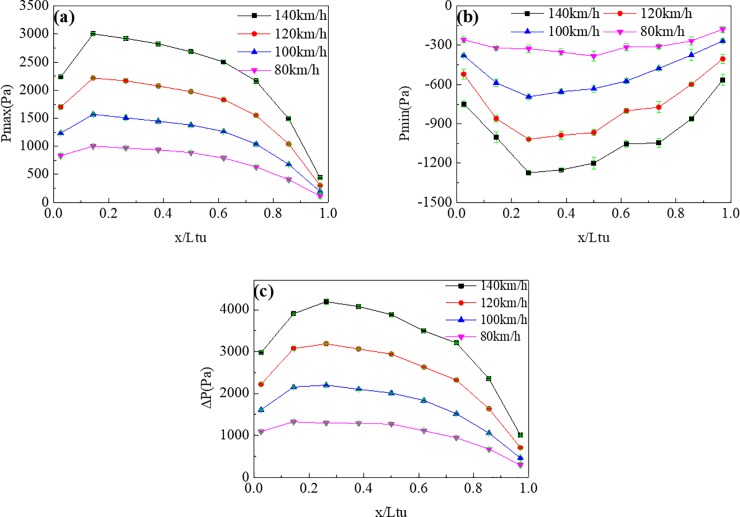
Pressure values at different points (z/H = 0.90) on the tunnel wall with different train speeds.(a), (b), and (c) show Pmax, Pmin, and ΔP, respectively.